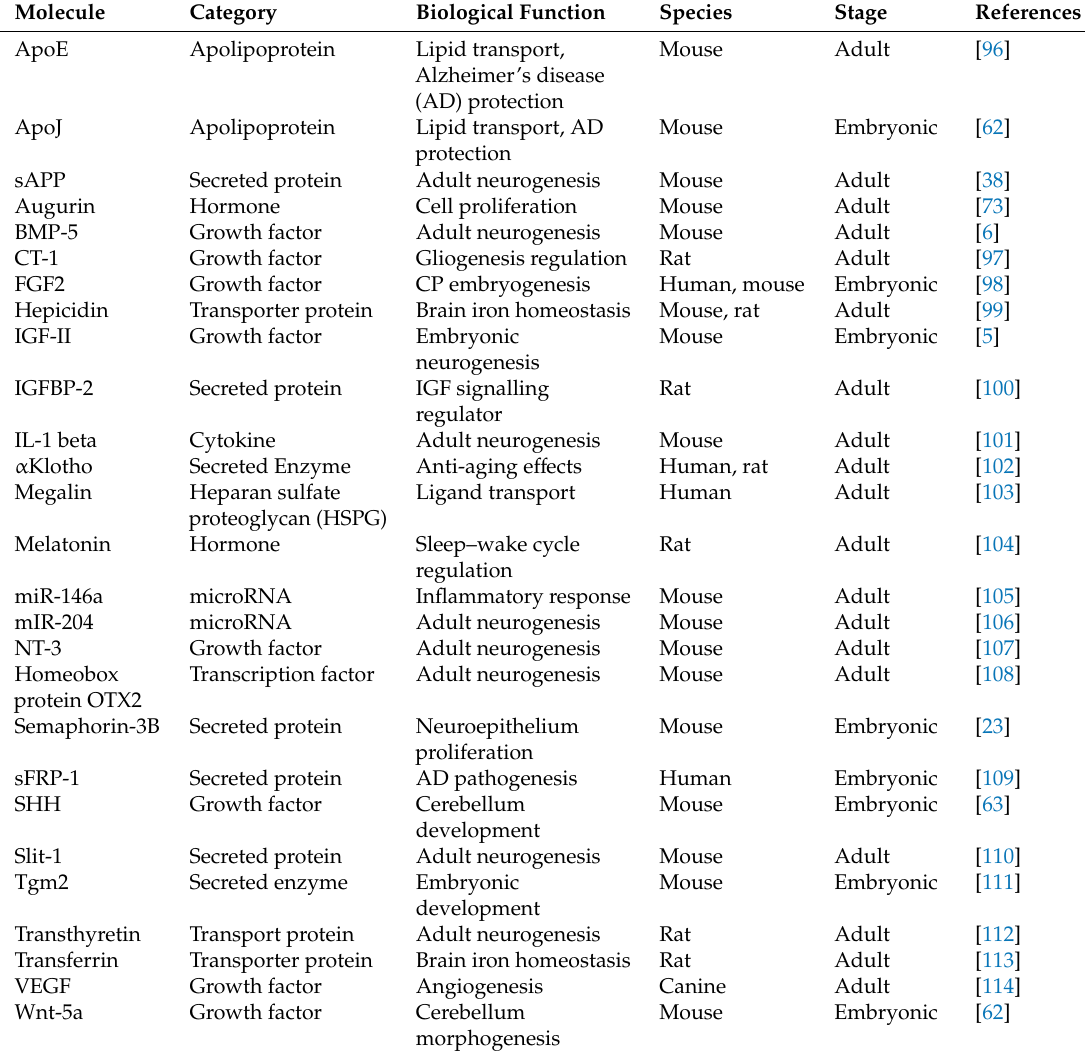
Table 1. List of signalling factors secreted by the choroid plexus